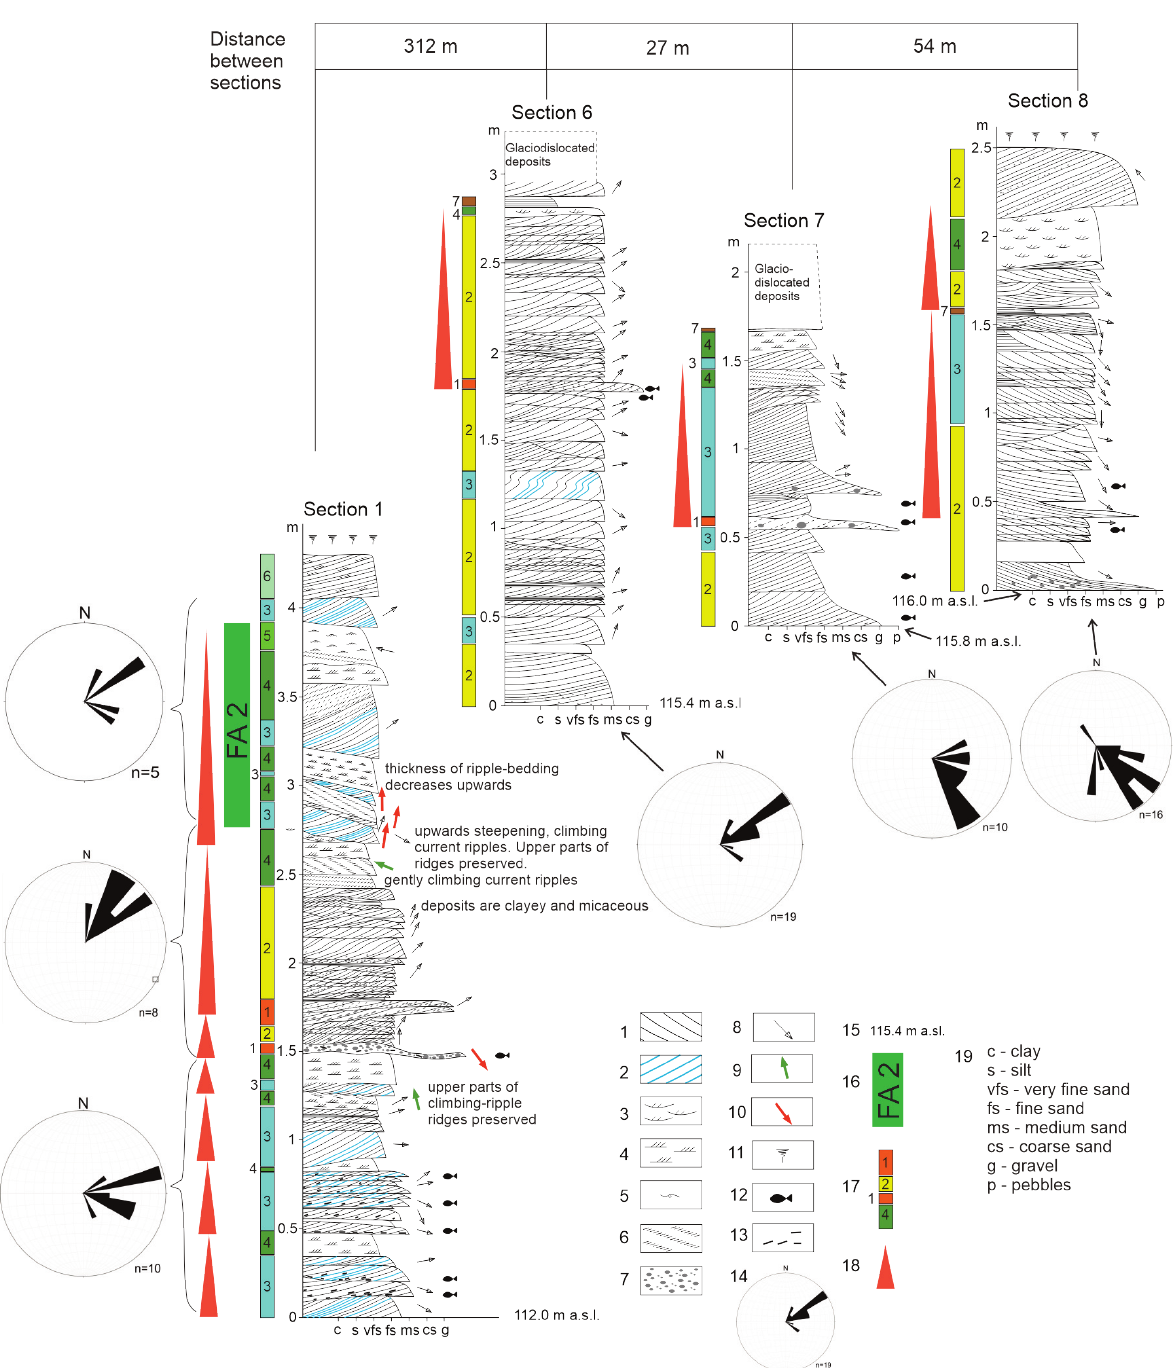
Fig. 3. Studied geological sections of the Frasnian Ogre Formation of the Gurova site. Legend: 1, cross­bedding and other structures; 2, mud and mica drapes (tidal features); 3, parallel current ripple­lamination; 4, trough current ripple­lamination; 5, wave ripple­ lamination; 6, climbing ripple­lamination; 7, clay clasts; 8, current direction derived from cross­bedding; 9, current direction derived from ripple­lamination; 10, master bedding surface dip azimuth; 11, soil and debris cover; 12, intervals of vertebrate finds; 13, vertebrate fossils in deposits; 14, rose diagrams of current directions derived from cross­bedding and ripple­lamination direction (‘n’ is the number of measurements); 15, hypsometric position of lower boundaries of sections; 16, facies association 2 (all the rest of deposits correspond to facies association 1); 17, facies and their numbers; 18, fining­upwards cycles; 19, grain­size of siliciclastic